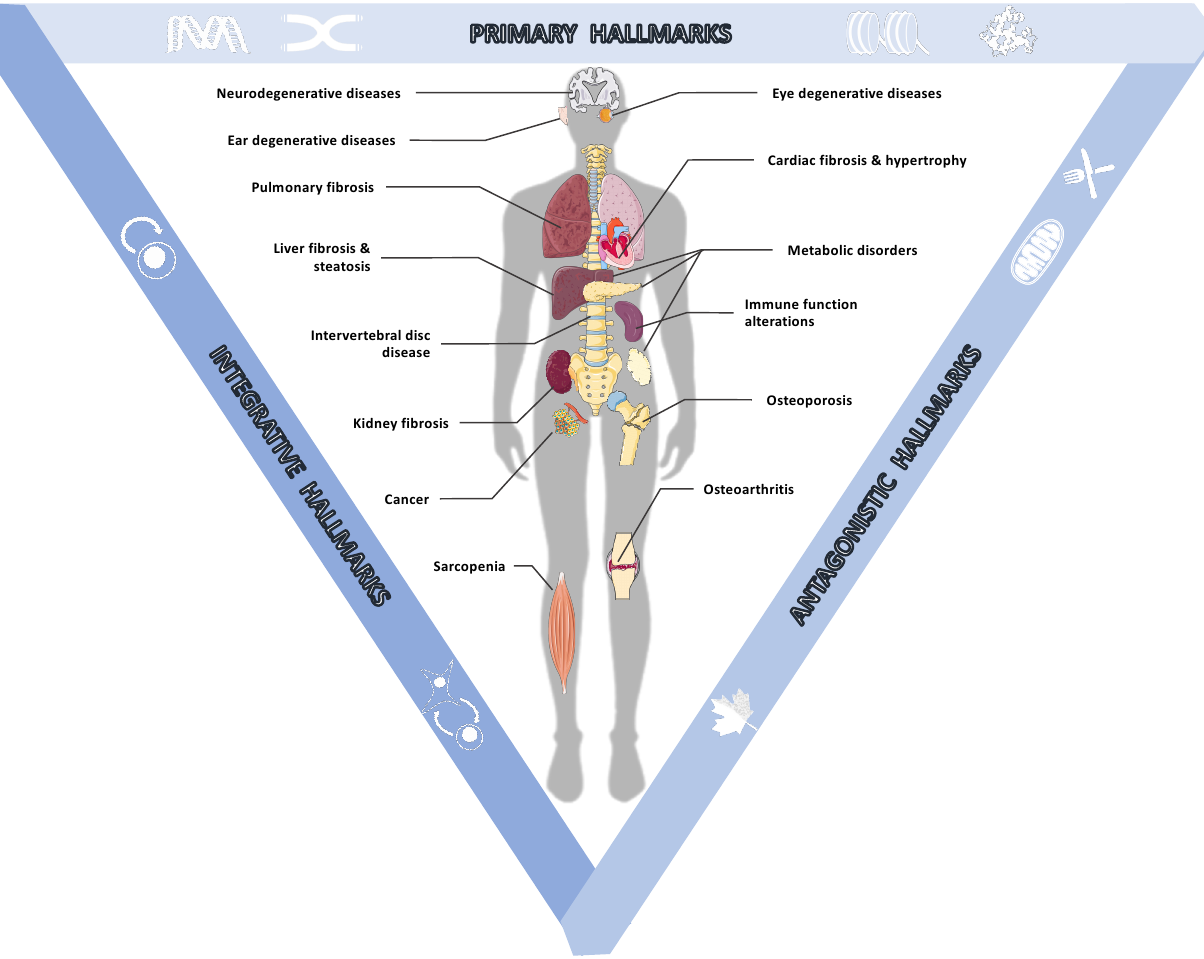
Figure 1. Hallmarks of aging at the origin of age-related diseases. Aging is characterized by a progressive loss of biological functions linked to the appearance and accumulation of molecular and cellular damage over entire lives. This damage has been classified into three categories by L ó pez-Ot í n [1]. (i) Primary hallmarks corresponding to molecular disorders occurring in cells: genomic instability, telomere attrition, epigenetic alterations, and loss of proteostasis. (ii) Antagonistic hallmarks, corresponding to alterations of damage response mechanisms: deregulated nutrient sensing, mitochondrial dysfunction, and cellular senescence. Finally, (iii) integrative hallmarks corresponding to tissue homeostasis failures: stem cell exhaustion and altered intercellular communication. Altogether, these interconnected hallmarks of aging act as cause and catalyst engendering a large set of age-related pathologies affecting the whole